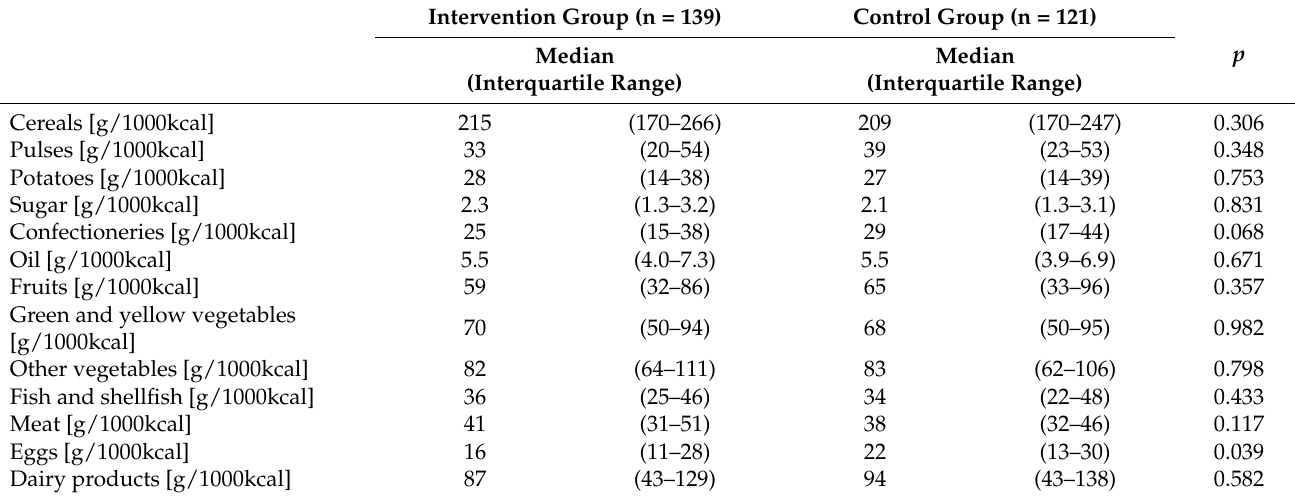
Table 3. Food consumption at 1 month